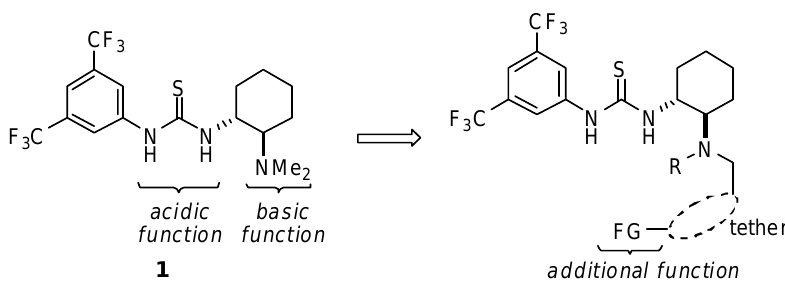
Figure 1. Design of a trifunctional thiourea catalyst.